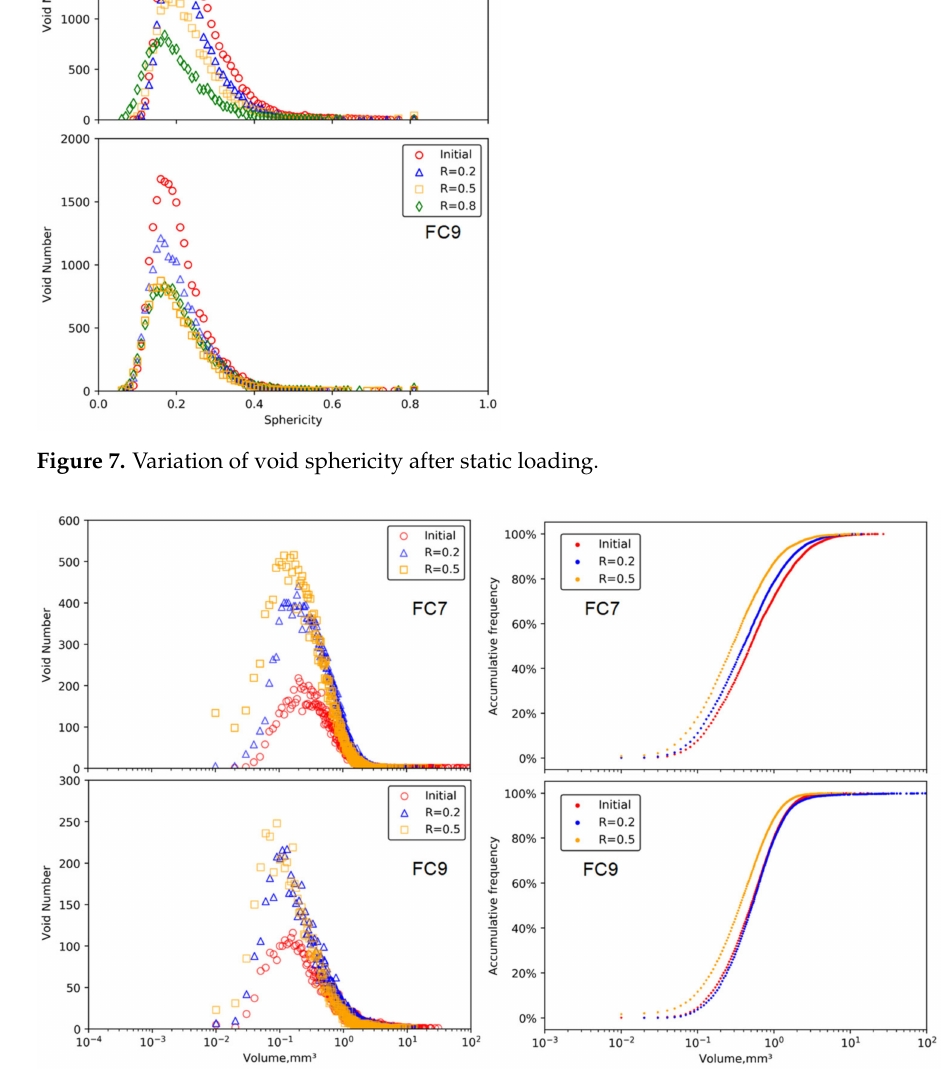
Figure 8. Change of void volume under plane strain cyclic compression loading. Table 3. Volume proportion of voids in different contact relationship under cyclic